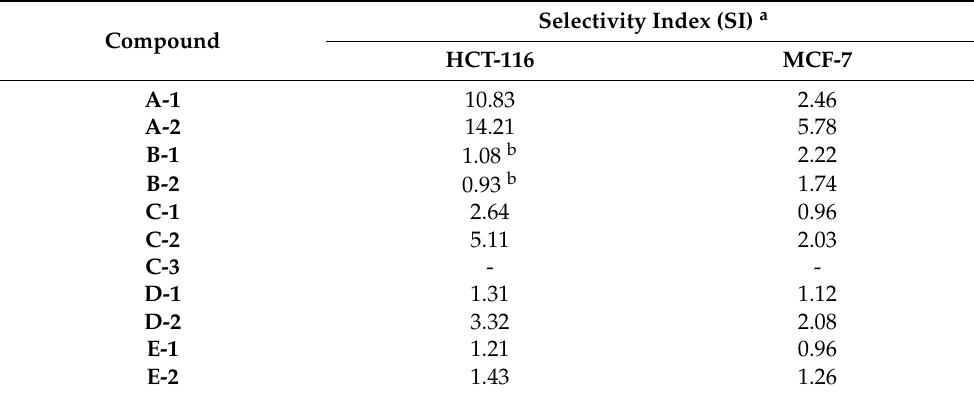
Table 3. Selectivity index (SI) of tested compounds after 72 h incubation time.